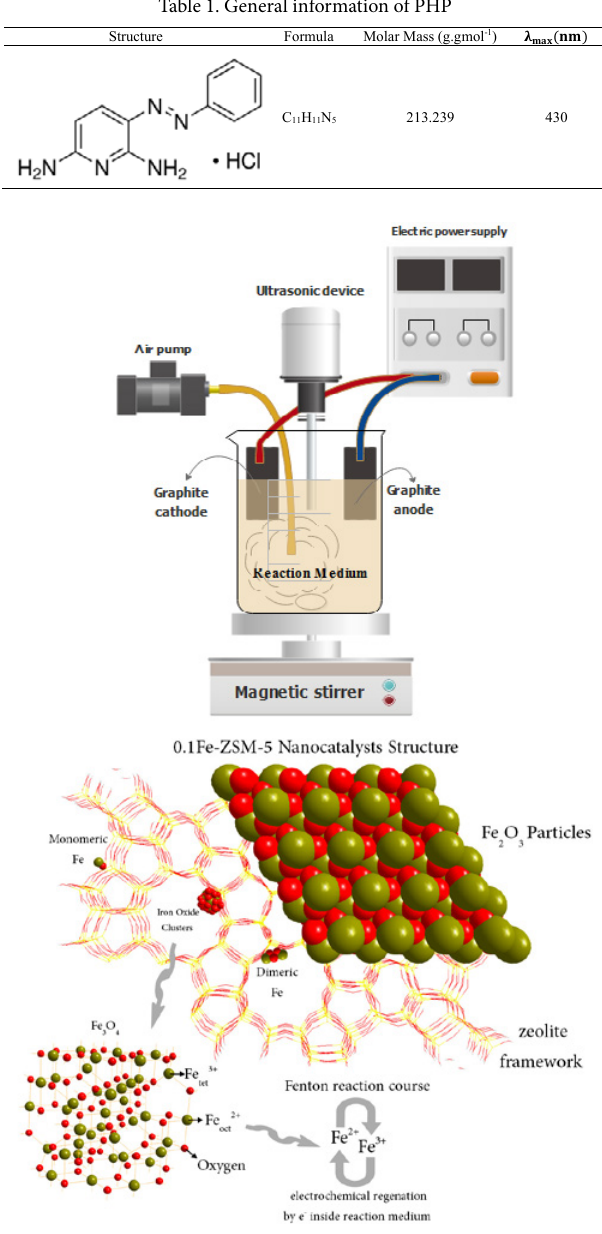
Fig. 1. Schematic of the HSEF bubble reactor and approximate structure of Fig.1